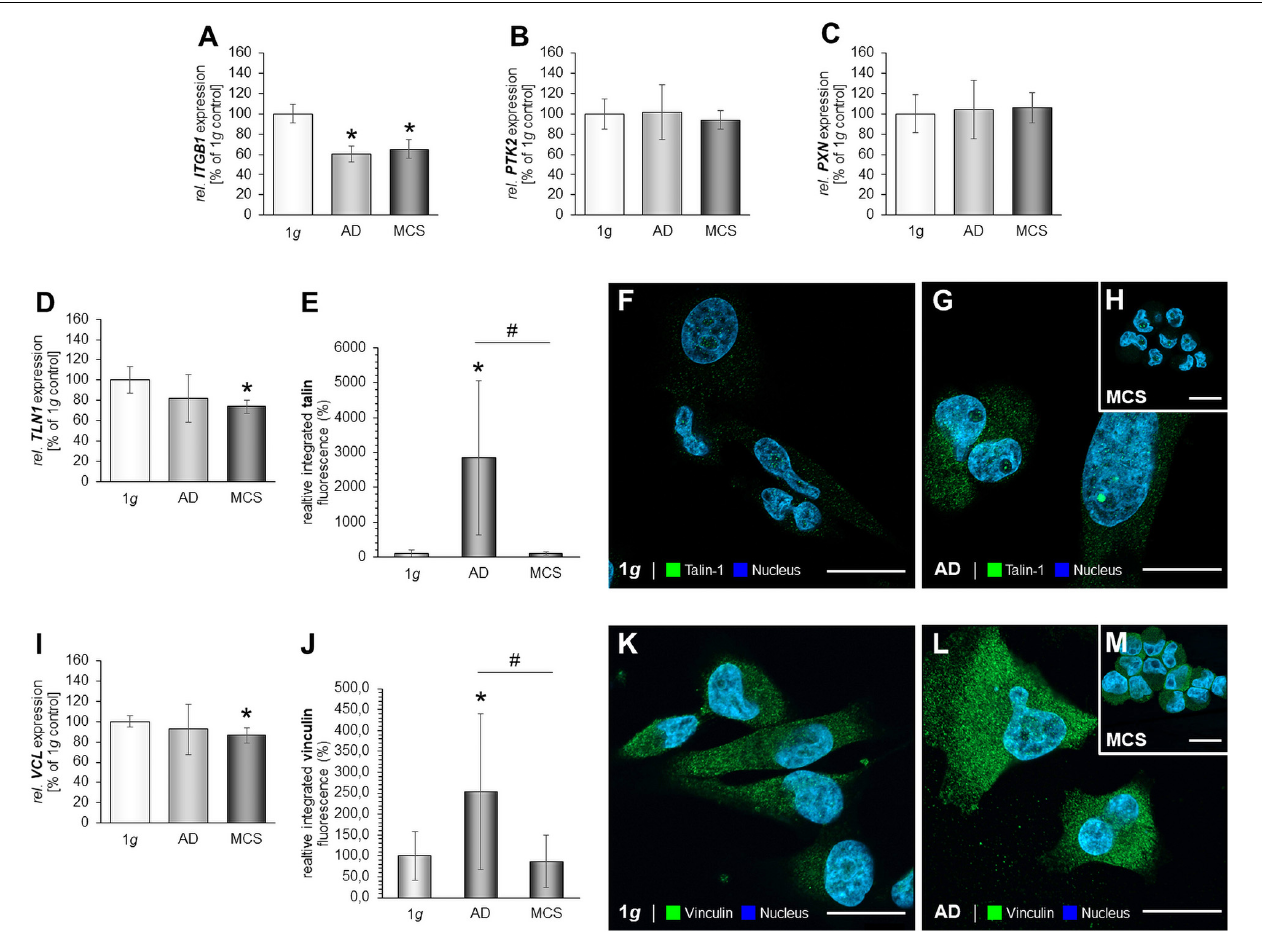
FIGURE 4 | Focal adhesions in MDA-MB-231 cells. The gene expression of ITGB1 (A) , PTK2 mRNA expression (B) , PXN mRNA expression (C) of MDA-MB-231 cells exposed to the RPM. In addition, the gene expression of TLN1 (D) and analysis of the fluorescence intensity of talin (E) , IFS of 1 g control cells (F) and RPM-exposed MDA-MB-231 cells [AD cells: (G) and MCS: (H) ] is given. Moreover, the VCL mRNA (I) and analysis of the fluorescence intensity of vinculin (J) , the IFS of vinculin are shown in 1 g control cells (K) and RPM-exposed AD cells (L) and MCS (M) . * p < 0.05 1 g vs. AD and/or MCS and # p < 0.05 AD vs.